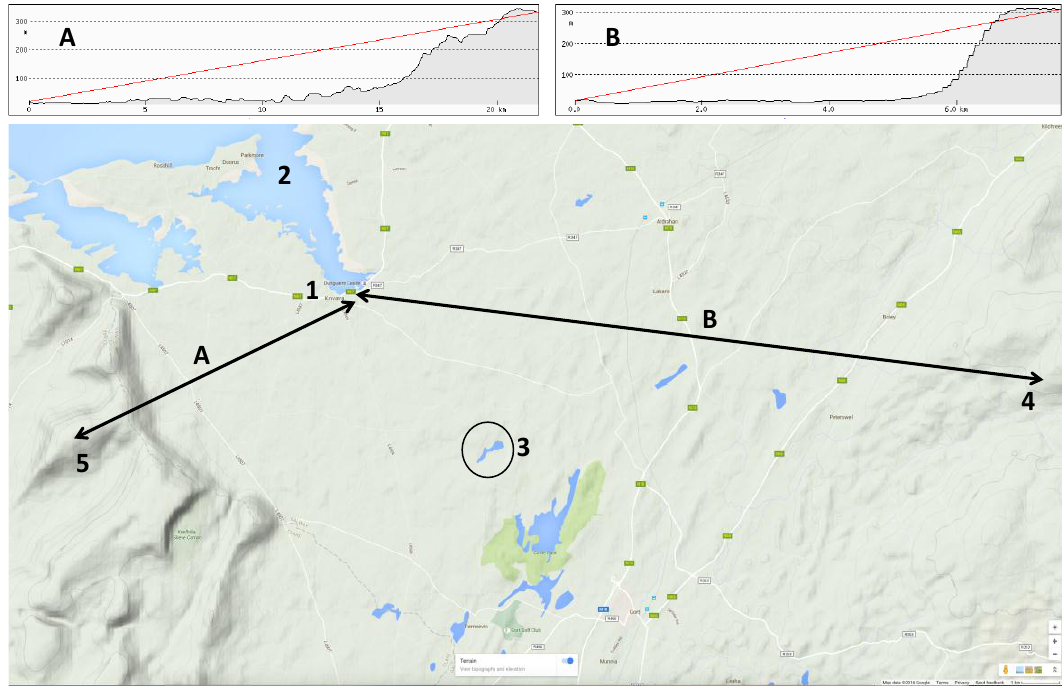
Figure 1. ( 1 ) Kinvara; ( 2 ) Kinvara Bay; ( 3 ) Caherglassuan Turlough; ( 1 – 4 ) Section A from Kinvara Eastwards towards Peterswell and the Slieve Aughty Region ( 4 ); ( 1 – 5 ) Section B from Kinvara Southwest towards Slieve Carran.